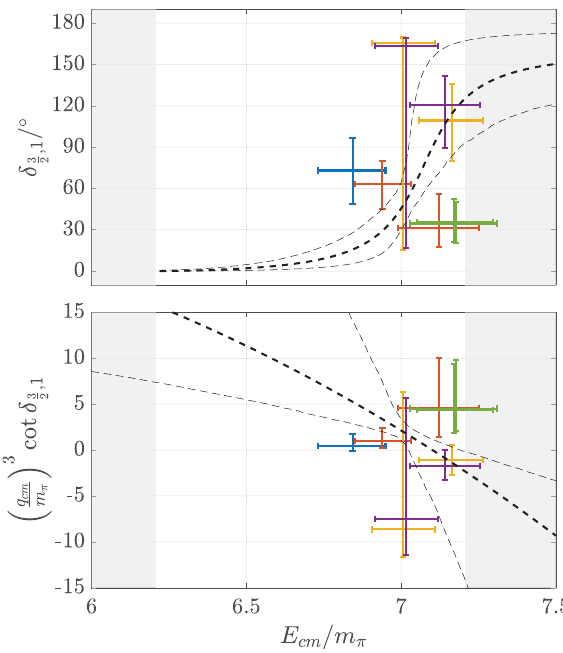
Figure 13. N π scattering phase shifts near the Δ resonance from Ref. [17] against the center-of-mass energy as a ratio over the pion mass. The top plot shows the phase shift itself, and the bottom plot shows the cotangent of the phase shift multiplied by threshold